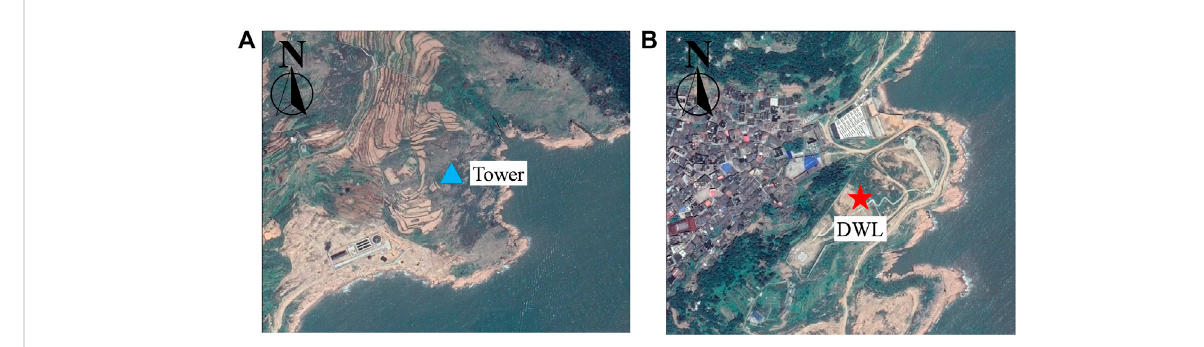
Terrain conditions at observation sites: (A) Wind tower; (B)